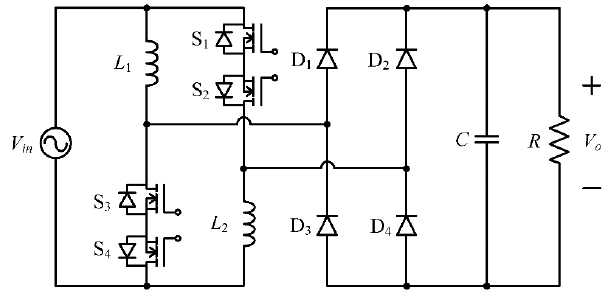
Figure 2. The proposed bridgeless high step-up voltage gain PFC converter.